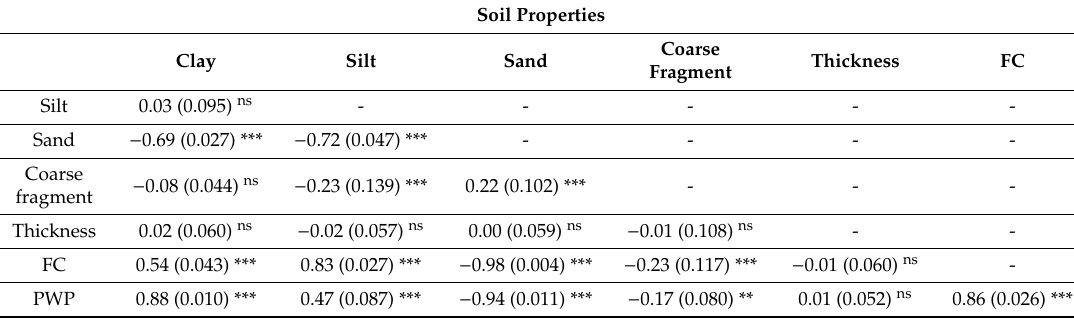
Table 7. Residuals correlations for soil property combinations.